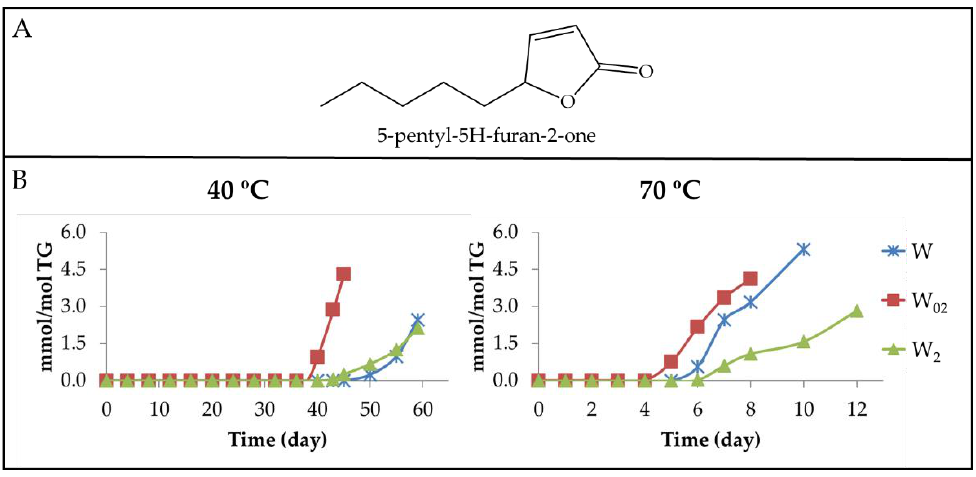
Figure 16. ( A ) Structure of one 5-alkyl-5H-furan-2-one. ( B ) Evolution of the concentration expressed as mmol/mol TG, of 5-alkyl-5H-furan-2-ones in walnut oil with different enrichment levels of αT (W, W 02 and W 2 ), submitted to either 40 °C or 70 °C up to advanced stages of the oxidation